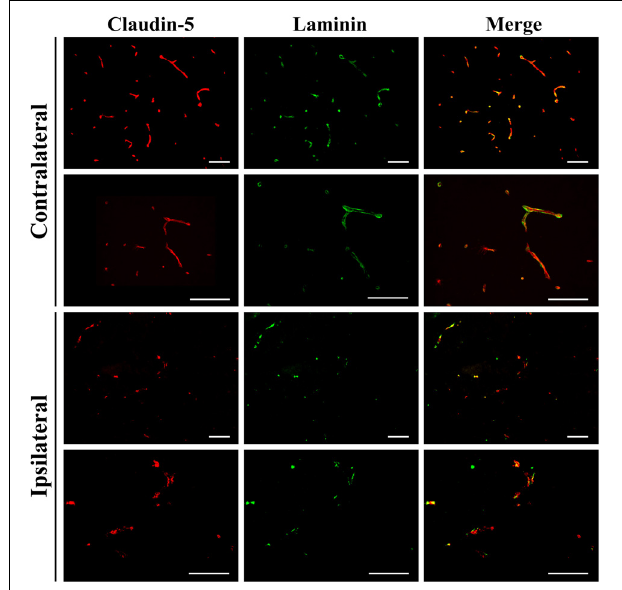
FIGURE 3 | Vascular damage 24 h after 0.3 U collagenase infusion. Immunofluorescence microscopy demonstrating representative claudin-5 and laminin expression in intact vessels of the contralateral striatum at × 20 (top row) and × 40 (second row) magnifications 24 h after 0.3 U collagenase ICV infusion. Conversely, within the ipsilateral striatum there is clear vessel rupture with loss of both claudin-5 and particularly of laminin, as seen at × 20 (third row) and × 40 (fourth row) magnifications ( n = 12). Scale bar = 100 µ